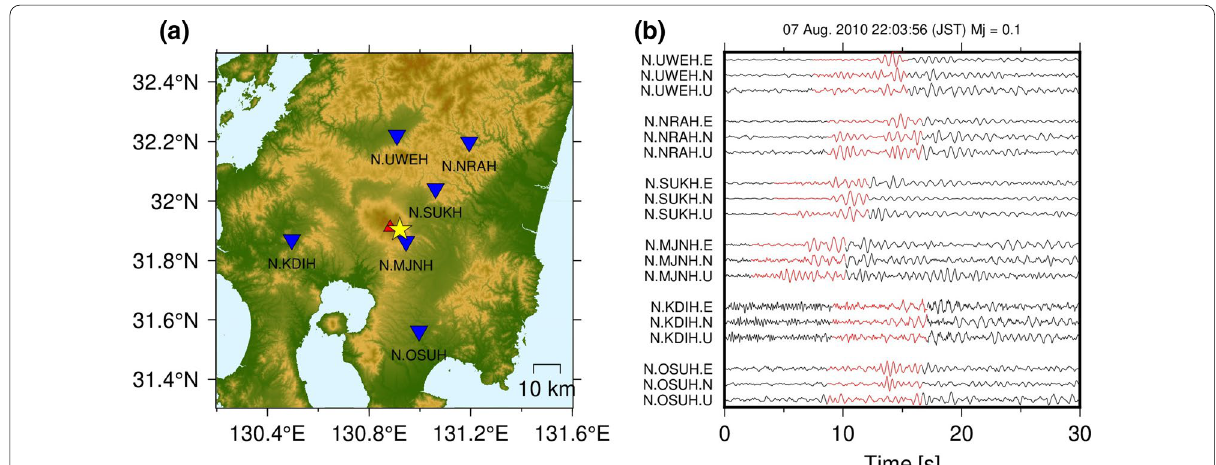
Fig. 2 a Distribution of Hi-net stations (blue inverted triangles) and the epicenter (yellow star) of the DLF earthquake (7 August 2010, 22:03:56, JST) used as a template here. The red triangle shows the location of Kirishima volcano. b Three-components, 1–8 Hz bandpass-filtered waveforms of the earthquake recorded at the six stations. The horizontal axis is the time elapsed from the origin. Red parts of the waveforms show the template waveform used in this